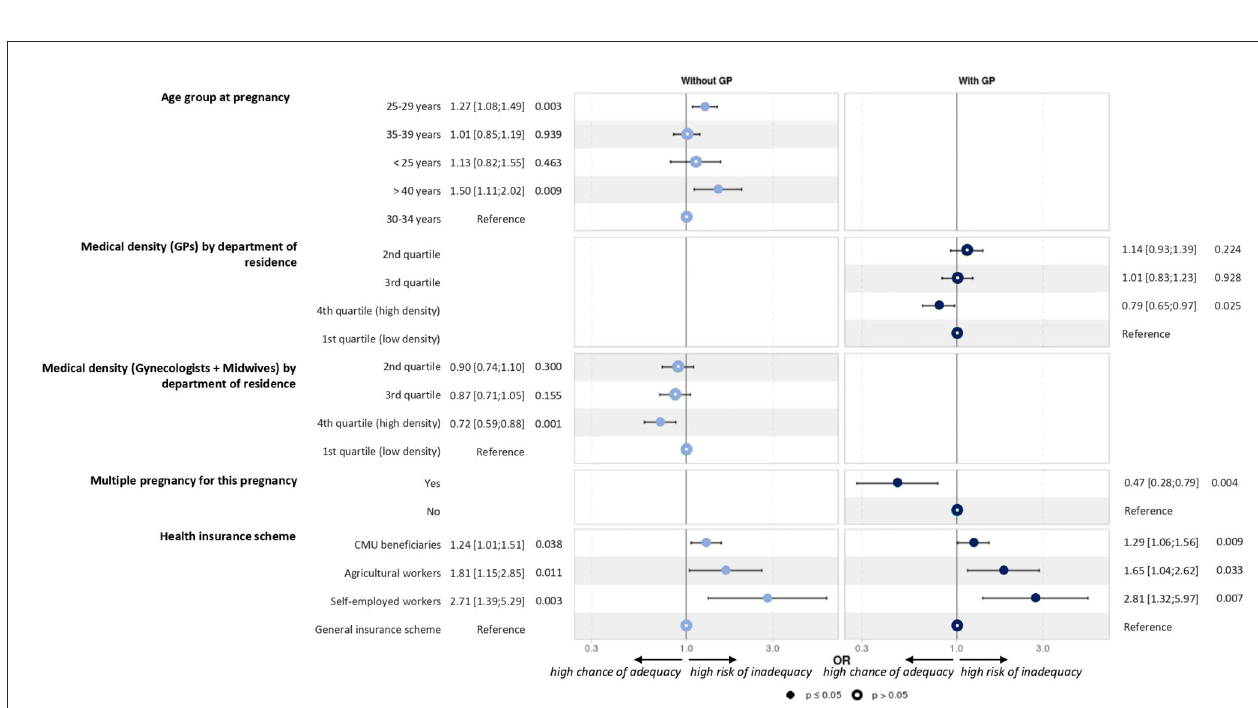
FIGURE3 Factors associated with adequate level of adherence to the prenatal care